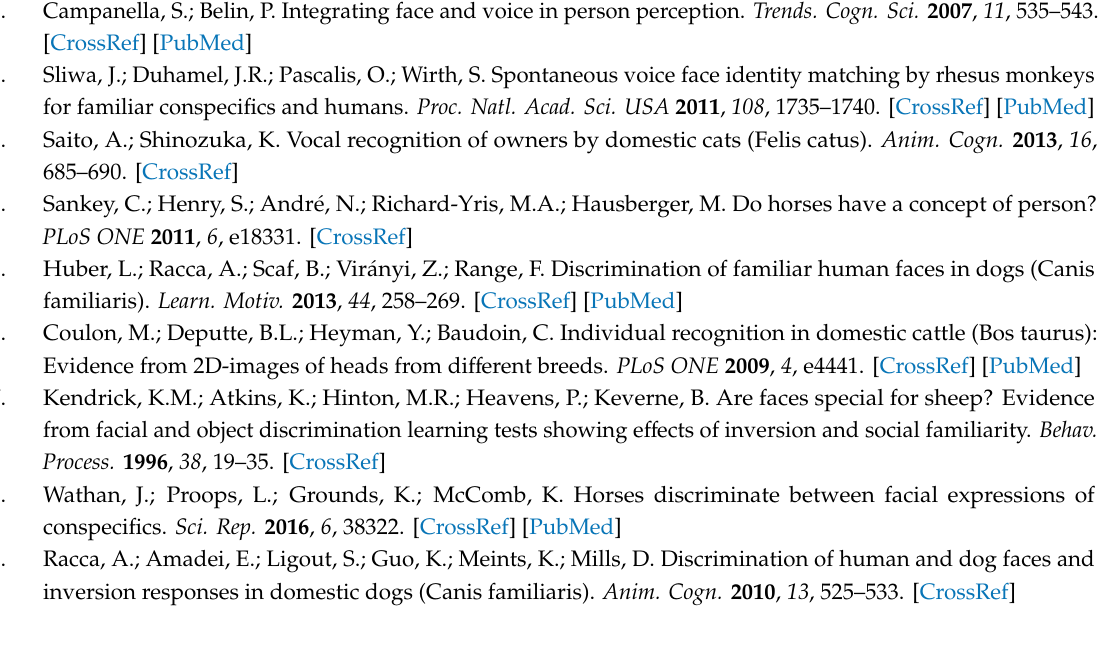
Table S1: List of behaviors scored according to the Stress / Anxiety